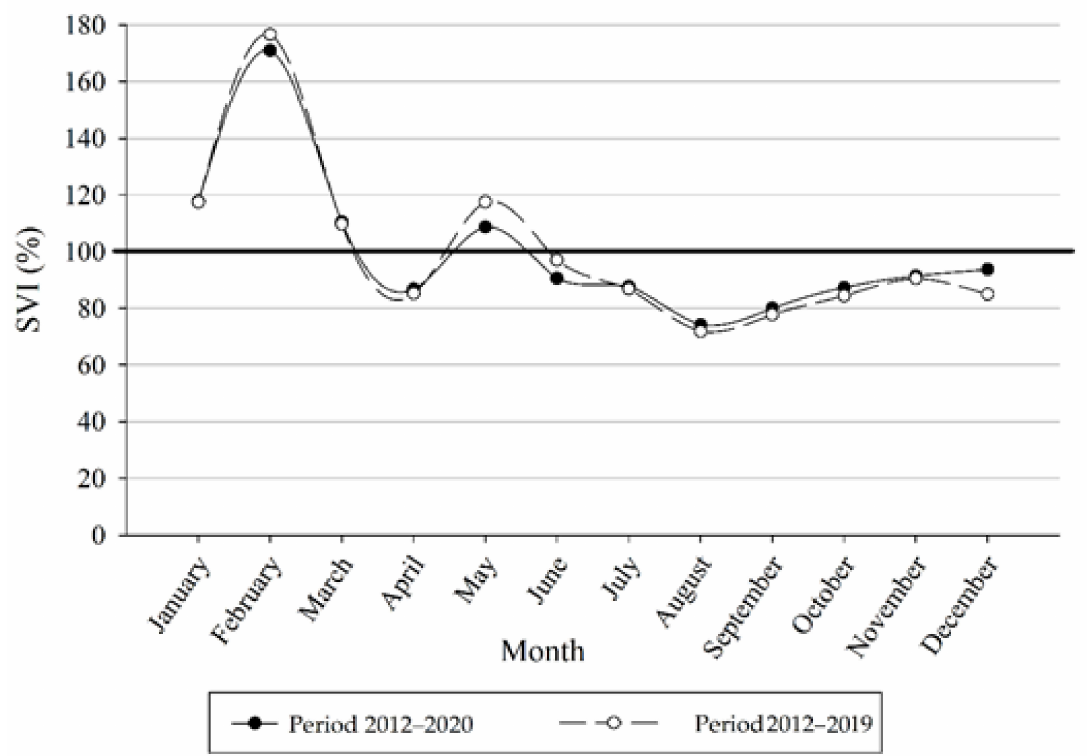
Figure 17. Seasonality pattern of vehicle disembarking traffic of the port of Tarragona during the periods 2012–2019